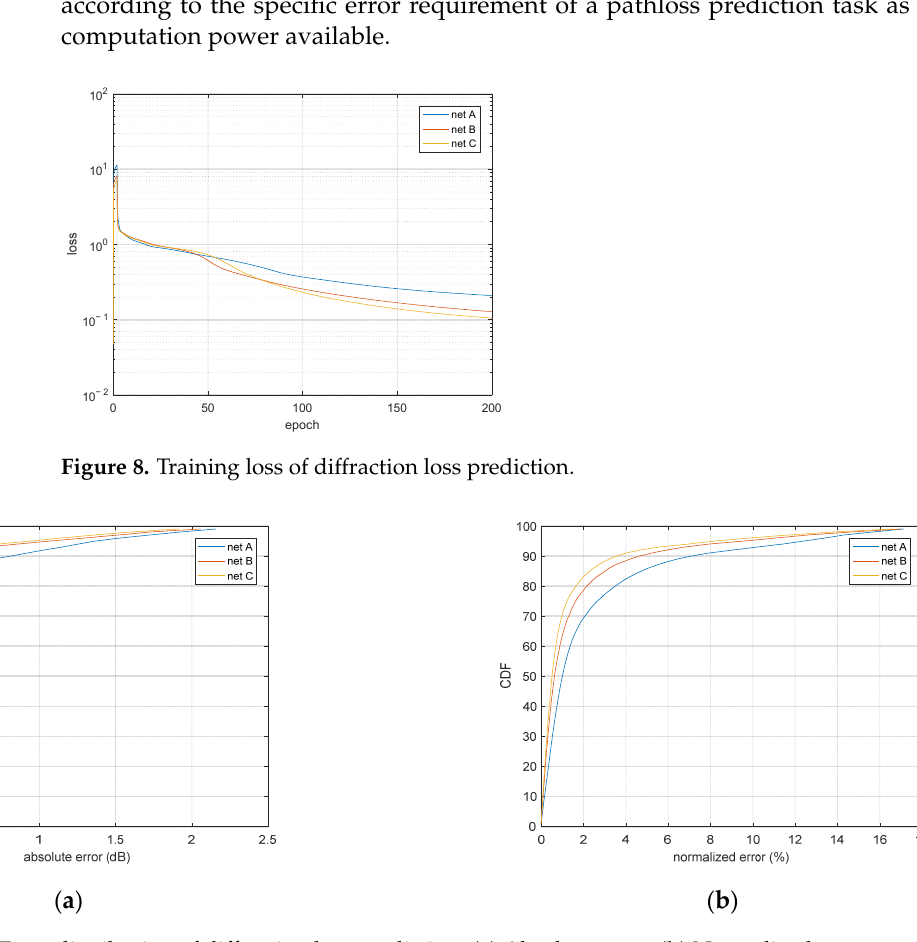
Figure 9. Error distribution of diffraction loss prediction. ( a ) Absolute error; ( b ) Normalized error.